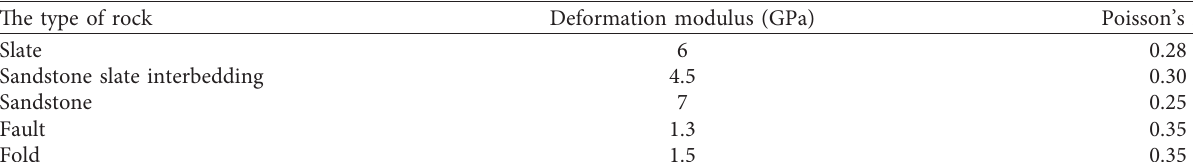
Table 2: Mechanical parameters of rock mass.